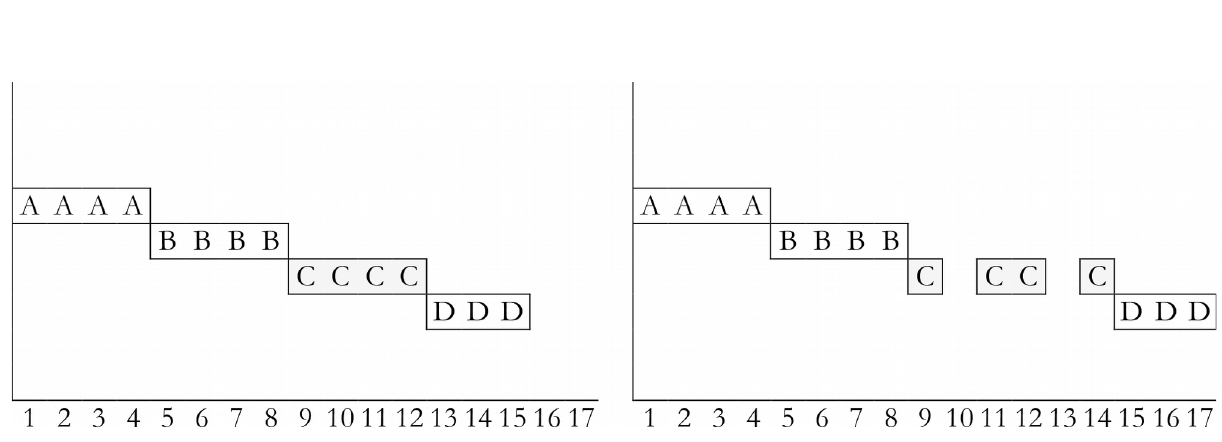
Figure 2. Comparing different styles of calculating ES with and without activity splitting (left to